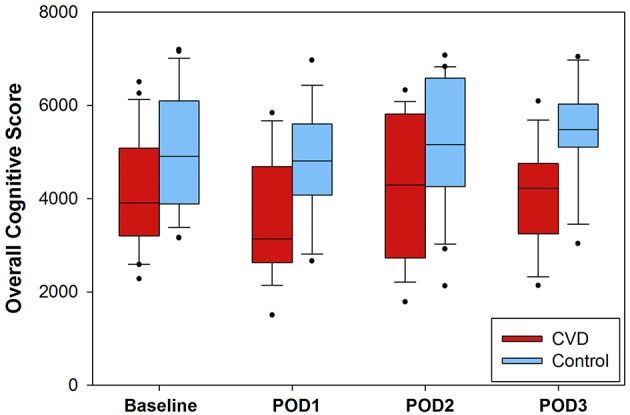
Composite cognitive function scores presented for each group. Higher scores were reflective of higher cognitive function. The interaction of group and time was not significant per generalized estimated equation modeling and was thus removed from the model. After adjusting for time, the cerebrovascular disease (CVD) group demonstrated significantly lower overall scores (approximately one standard deviation) compared to the control group (−1049, 95% CI: −1662, −436; P < 0.001). The number of daily assessments available were as follows: baseline, N = 24 (CVD group) and N = 24 (control group); POD1, N = 18 (CVD group) and N = 19 (control group); POD2, N = 19 (CVD group), and N = 20 (control group); POD3, N = 13 (CVD group) and N = 14 (control group). POD = postoperative day.